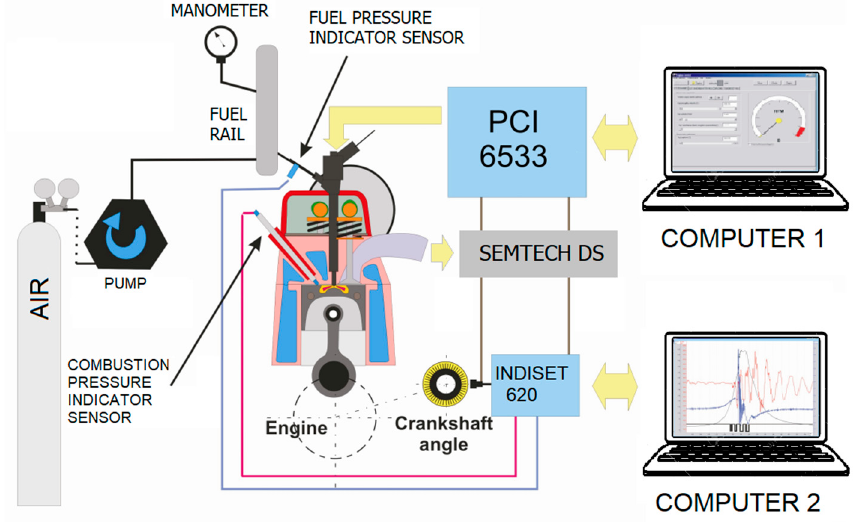
Figure 4. The test